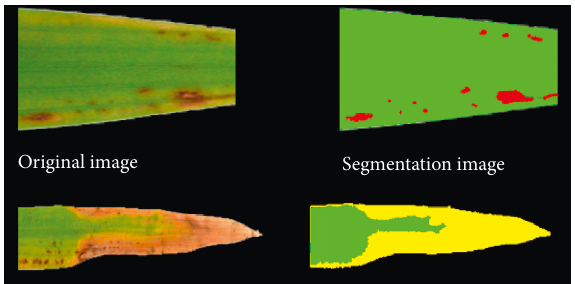
Figure 8: Comparison between original image and segmentation image.